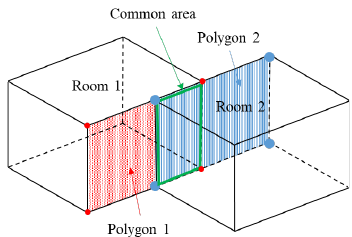
Figure 5. Case 4: Both rooms share a common surface without sharing their edges and none is contained in the other.